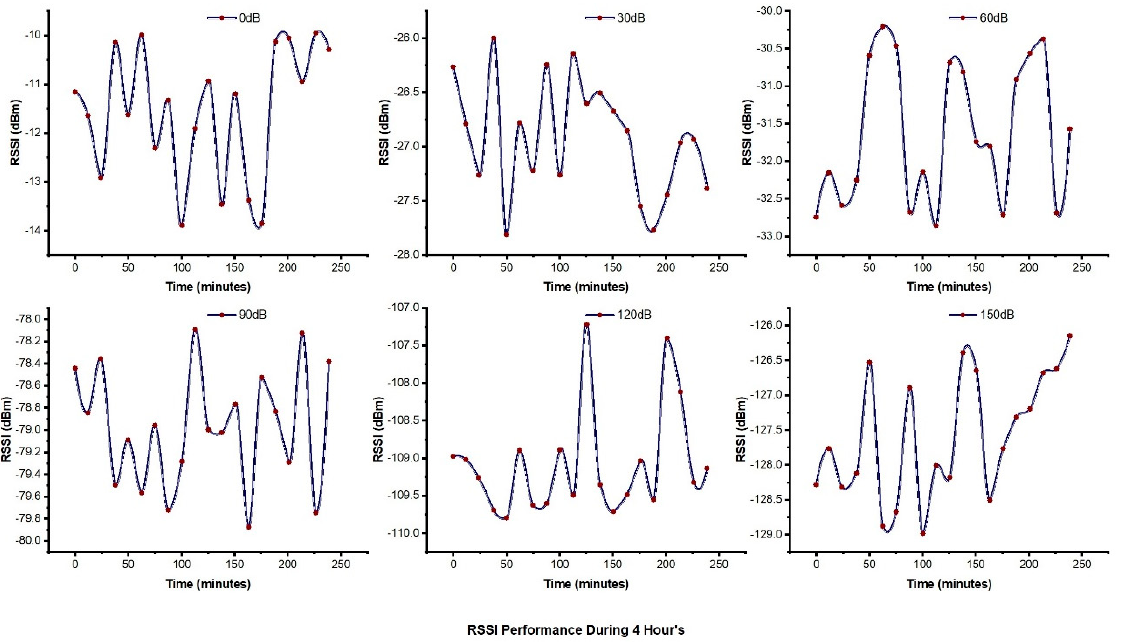
Figure 10. Observed Received Signal Strength Indicator (RSSI) at various attenuation levels during the four − hour window.